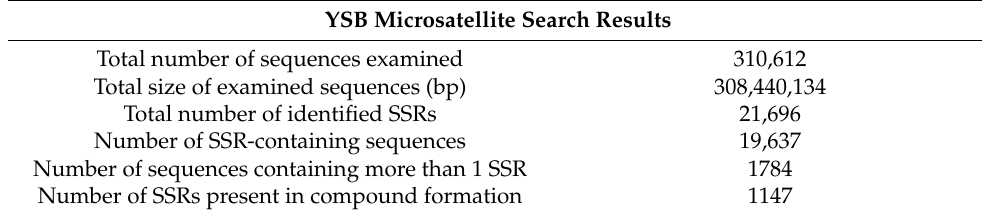
Table 4. Genomic SSR statistics.